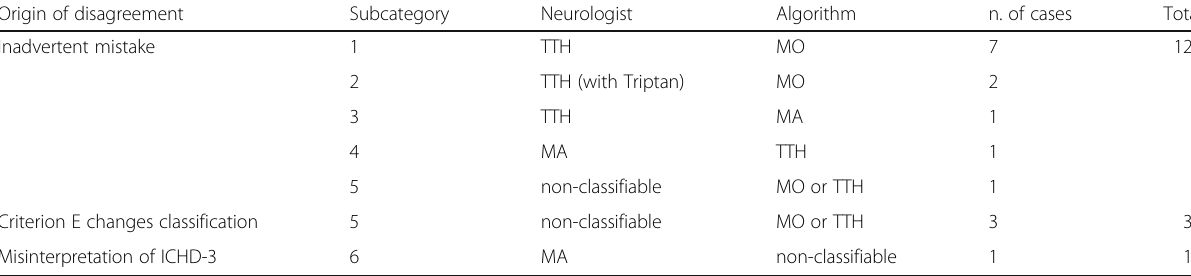
Table 3 Subcategories identified by the disagreement validity assessment Origin of